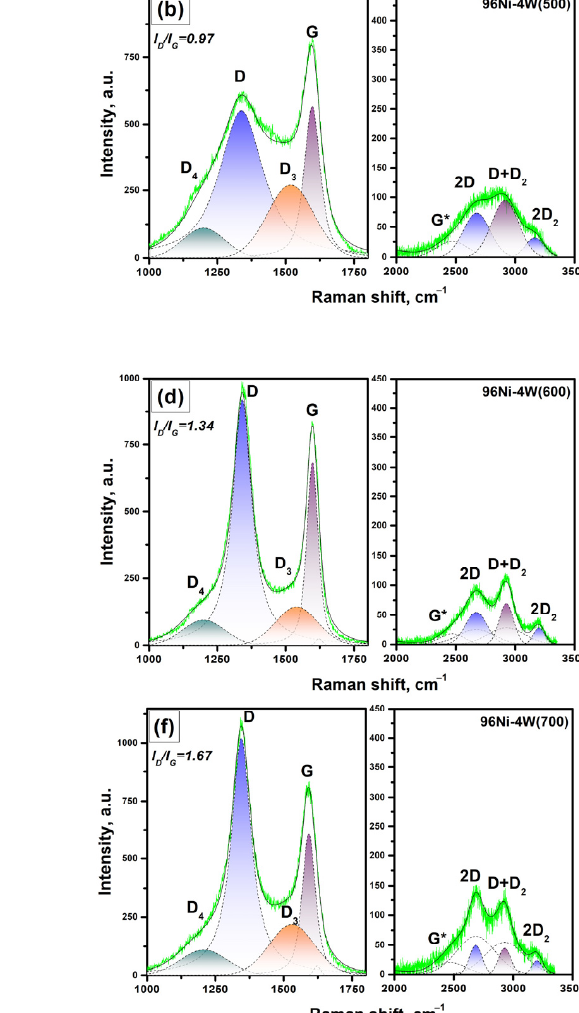
Figure 9. Raman spectra of the carbon product formed over the 96Ni-4W samples for a region of the bands of first and second orders: ( a ) 96Ni-4W(475); ( b ) 96Ni-4W(500); ( c ) 96Ni-4W(550); ( d ) 96Ni-4W(600); ( e ) 96Ni-4W(650); ( f ) 96Ni-4W(700).